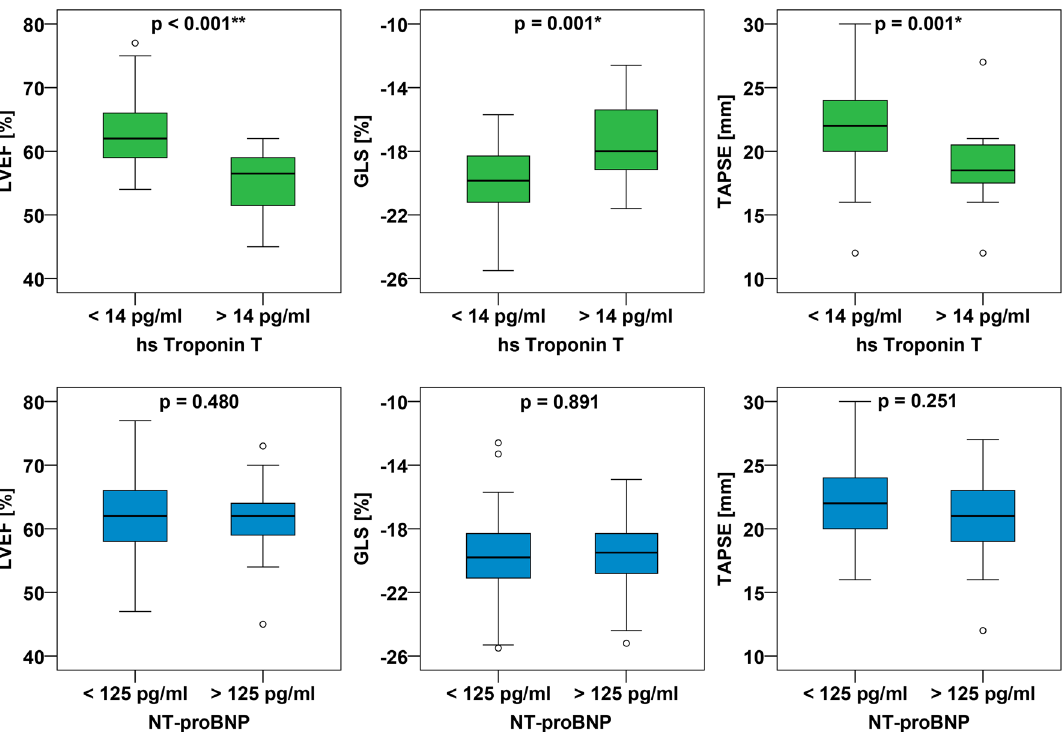
Figure 3. Association between echocardiographic parameters and cardiac biomarkers. Upper panel Boxplots of LVEF, GLS, TAPSE according to hs troponin T cut off 14 pg/ml 29 . Lower panel Boxplots of LVEF, GLS, TAPSE according to NT-proBNP cut off 125 pg/ml 30 . Hs troponin T = high sensitive troponin T; NT-proBNP = N-terminal pro brain natriuretic peptide; LVEF = left ventricular ejection fraction; GLS = global longitudinal strain; TAPSE = tricuspid annular plain systolic